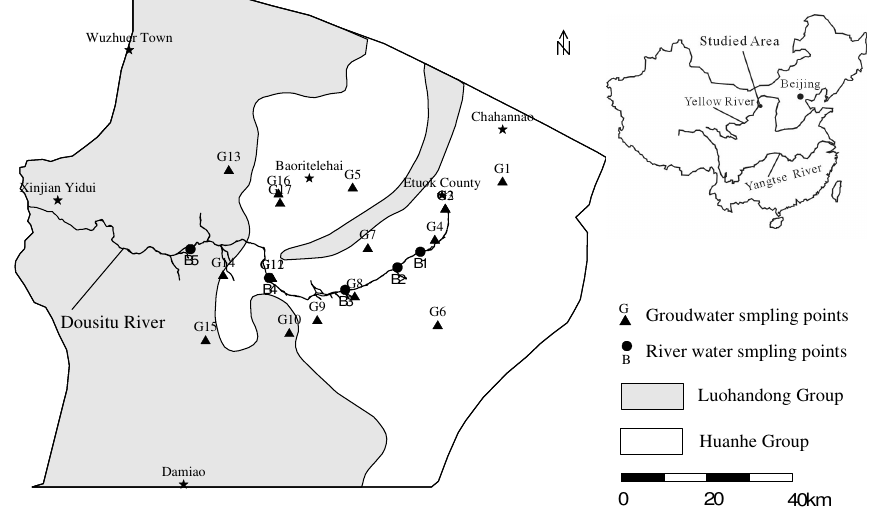
Figure 1. Location of the study area and the sampling